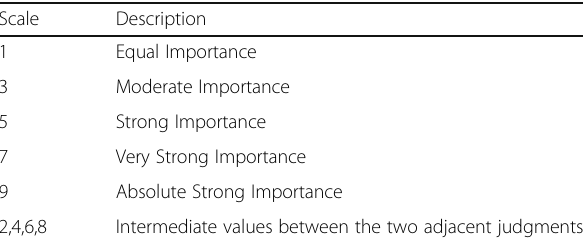
Table 4 Fundamental scale of Saaty ’ s